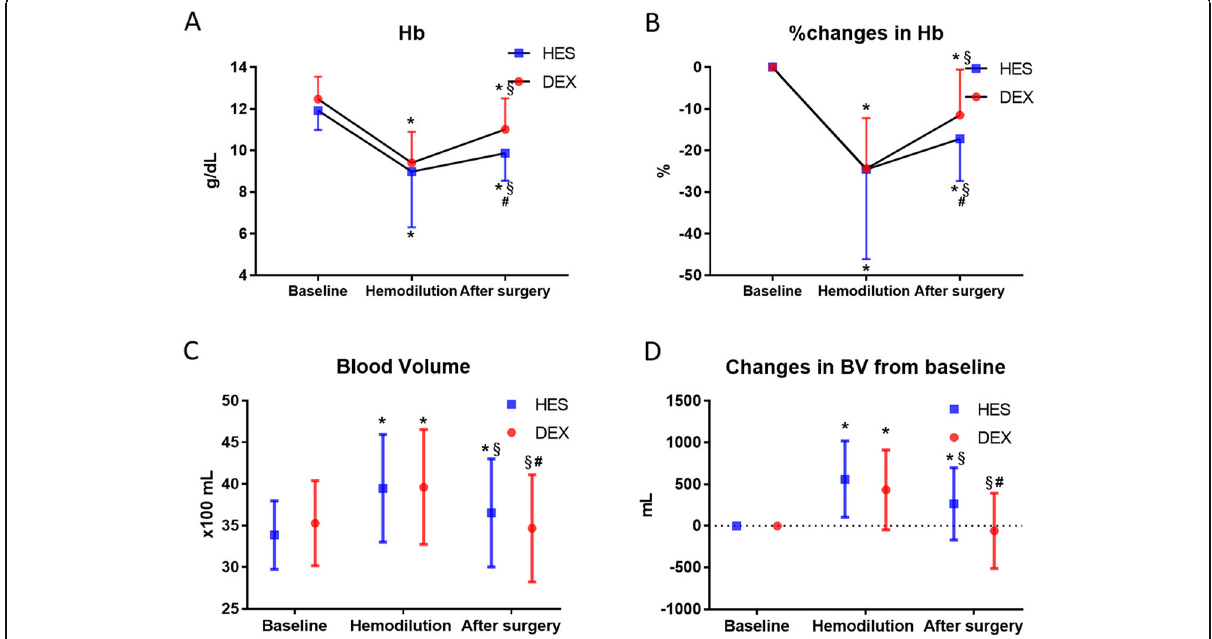
Fig. 1 Difference in hemoglobin concentration and blood volume between the HES group and the DEX group. A Changes in hemoglobin concentration. B %Changes in hemoglobin concentration. C Changes in blood volume. D Changes in blood volume from the baseline value; HES, hydroxylethyl starch; DEX, dextran; Hb, hemoglobin concentration; BV, blood volume; * p < 0.01 vs. baseline. § p < 0.01 vs. hemodilution. # p < 0.01 vs.